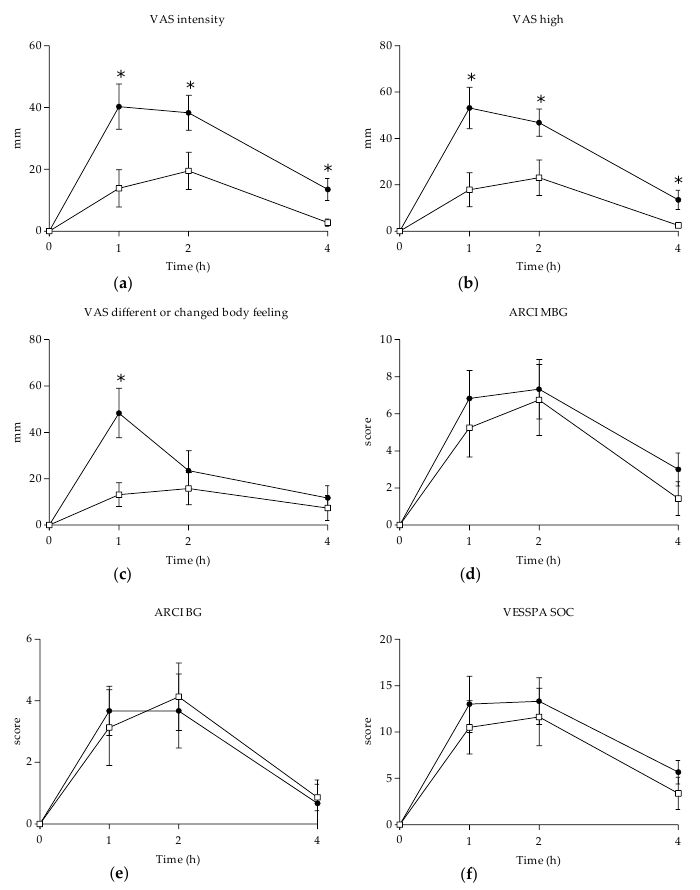
Figure 2. Summary of the time course of subjective effects collected through VAS (intensity ( a ), high ( b ), different or changed body feeling ( c )), ARCI (MBG (euphoria) ( d ), BG (intellectual efficiency) ( e )), and VESSPA-SSE (SOC (pleasure and sociability) ( f )) questionnaires after methylone and MDMA oral administration. ( □, 10 0 – 300 mg methylone ( n = 8) ; ●, 75 – 100 mg MDMA ( n = 6); mean, standard error). Statistical differences of p < 0.05 between conditions are indicated with “*”. See text for abbreviations.